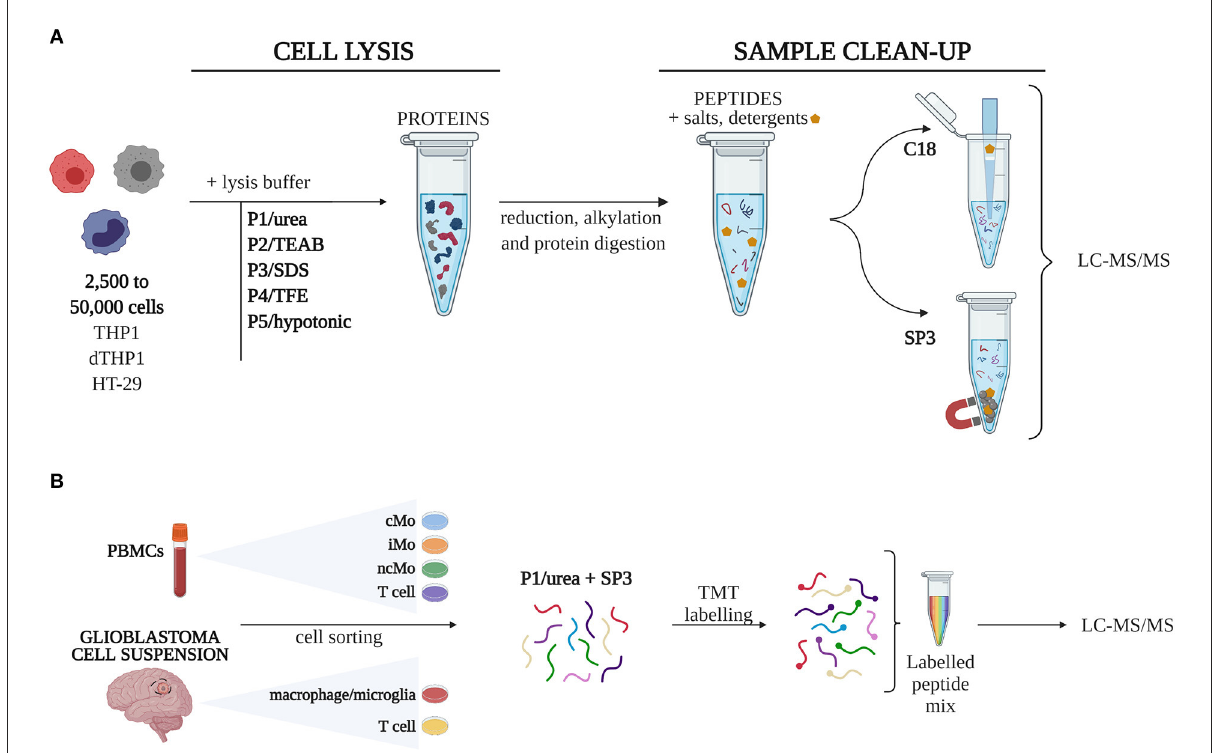
FIGURE1 Experimental design. (A) Five different cell lysis buffers were combined with C18 and SP3 clean-up approaches to define 10 procedures, which were tested for their performance on quantity-limited samples (2,500 to 50,000 cells). (B) The combination of urea-based lysis buffer and SP3 was applied to study different monocytic subsets isolated from peripheral blood mononuclear cells (PBMCs) and macrophages from glioblastoma. Samples were labelled with TMT16-plex tags for quantitative analysis. cMo, classical monocytes; iMo, intermediate monocytes; LC-MS/MS, liquid chromatography-tandem mass spectrometry; ncMo, non - classical monocytes; SDS, sodium dodecyl sulfate; SP3 , single-pot, solid-phase-enhanced sample preparation method; TEAB, triethylammonium bicarbonate; TFE, 2,2,2-trifluoroethanol; TMT, tandem mass tag [Created with